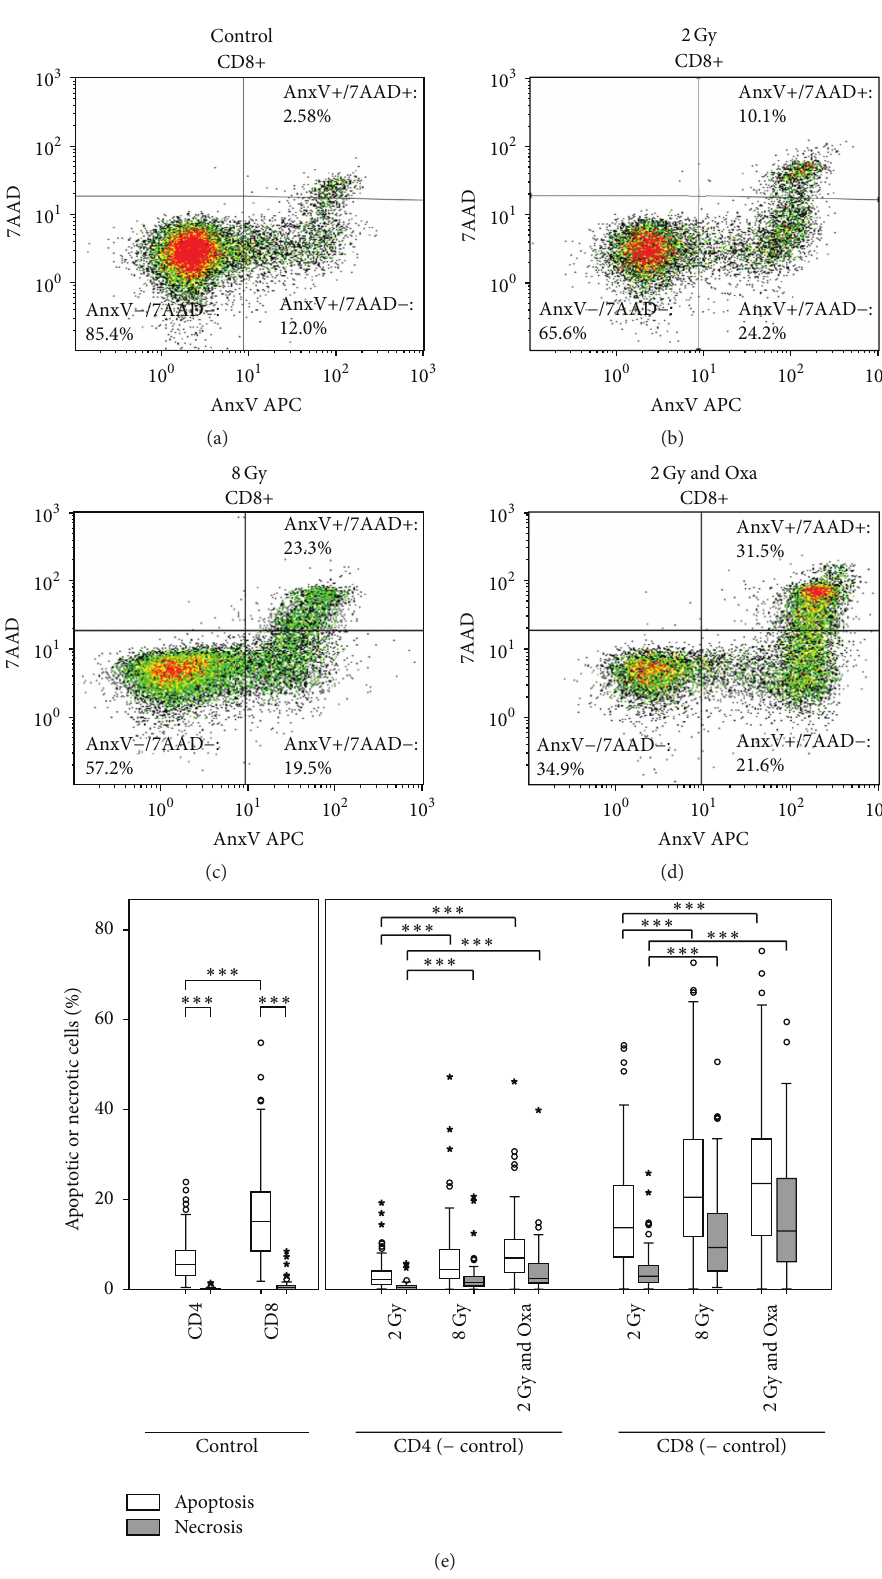
Figure 1: Evaluation of apoptotic and necrotic rates of CD8+ cells with the cell analysis software Kaluza, showing an example of (a) untreated samples, (b) samples treated with 2 Gy ionizing radiation, (c) samples treated with 8 Gy ionizing radiation, and (d) samples treated with 2Gy ionizing radiation combined with 10 𝜇 g/mL Oxaliplatin. (e) Apoptotic (white bars) and necrotic (grey bars) rates in percentages by treatment and lymphocyte subgroups CD4+ and CD8+ of 87 rectal cancer patients. Control values represent the apoptotic or necrotic background and were subtracted from the values of the treated samples. Significantly different values were marked by three asterisks ( 𝑝 < 0.001